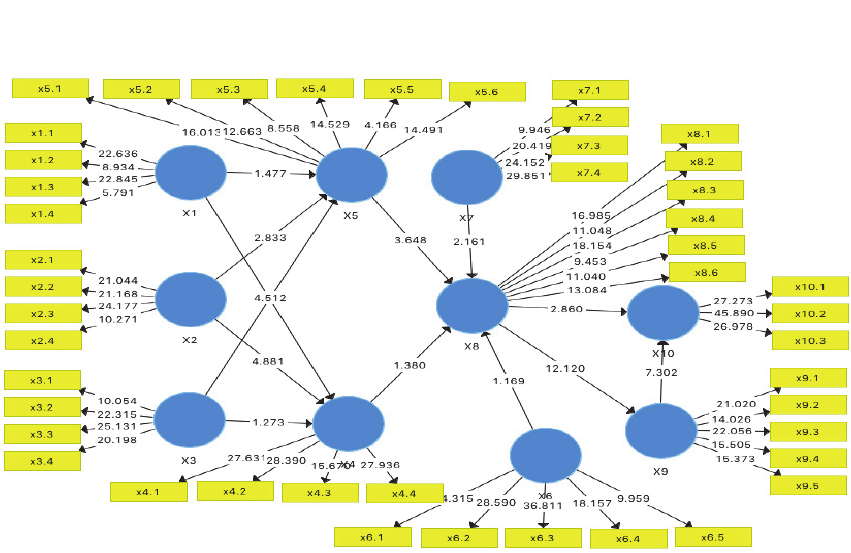
Path Coefficients (Mean, STDEV, T-Values, P-Values Variabel Original Sample (O) Sample Mean (M) Standard Deviation (STDEV) T Statistics (|O/STDEV|) P Values X1 → X4 0.330